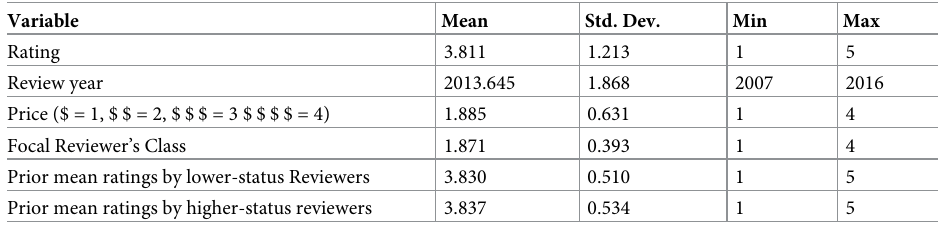
Table 1. Descriptive statistics of variables used in Study 1 (based on the sample for model 4). Variable Mean Std.